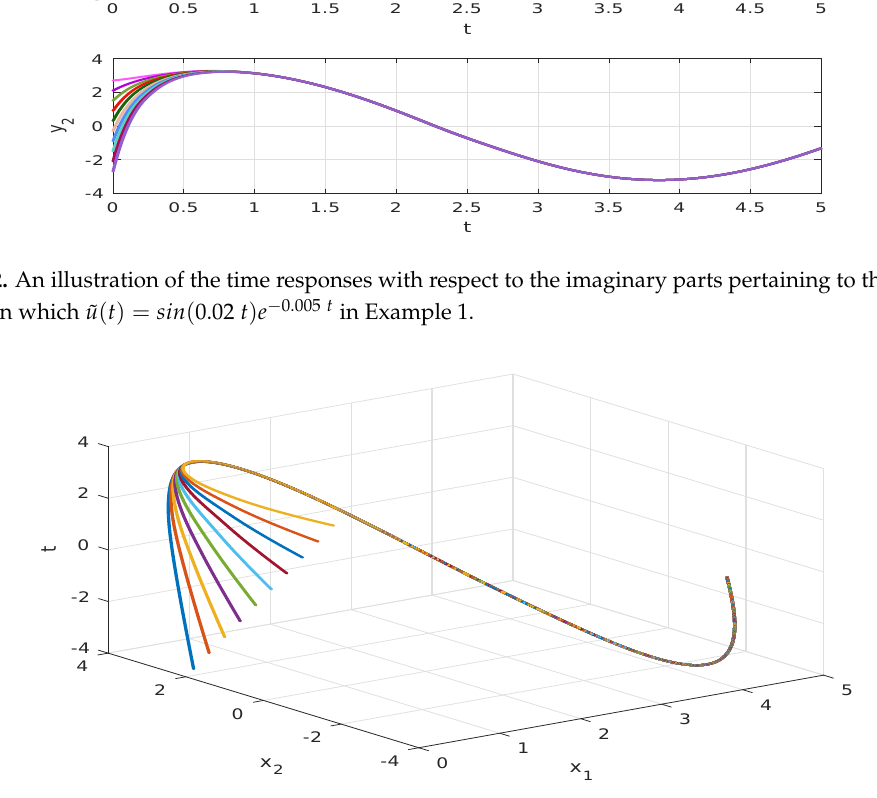
Figure 3. An illustration of the time responses between the real subspace pertaining to the model in (20), in which ˜ u ( t ) = sin ( 0.02 t ) e − 0.005 t in Example